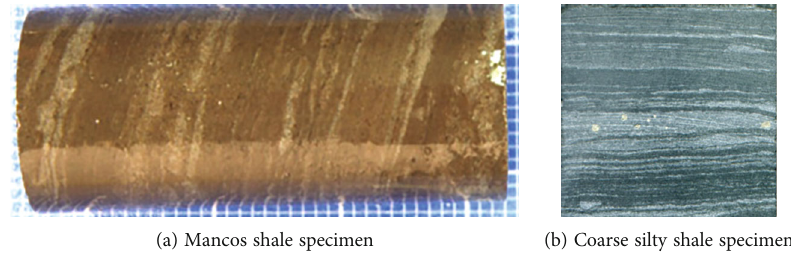
Figure 1: Shale specimen developed multiple layers with di ff erent mechanical properties [1,